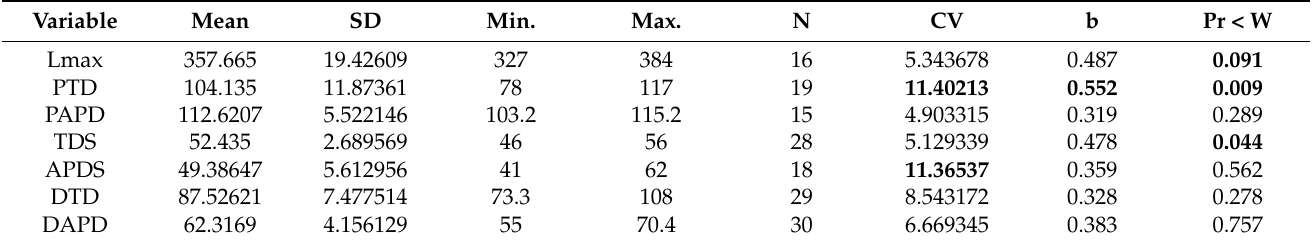
Table 2. Sex-combined statistics for tibia variables.